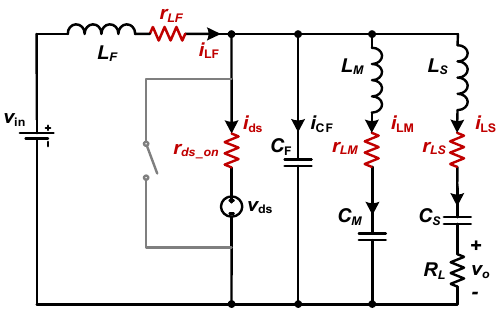
Figure 4. Circuit model for a class Φ 2 inverter considering inductor parasitic resistance and power switch on-resistance.